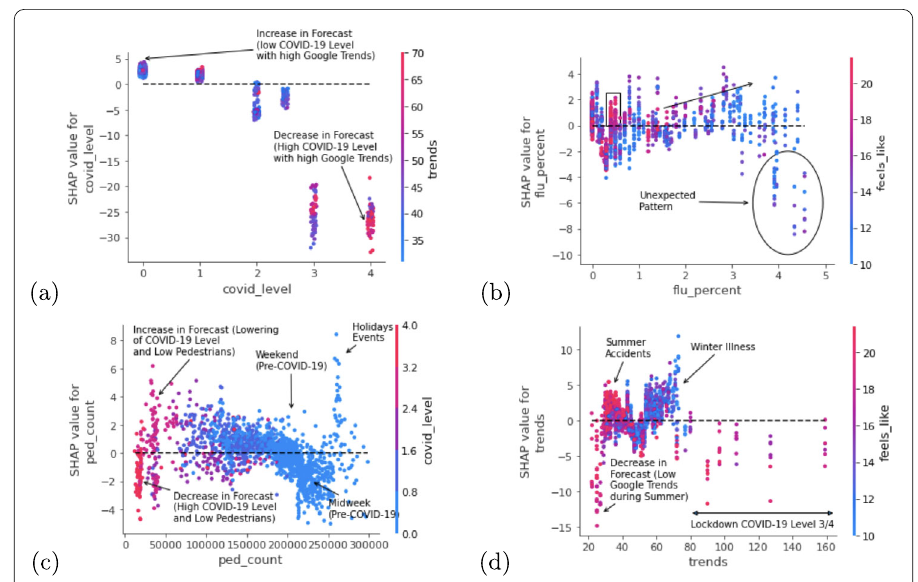
Figure 10 SHAP feature dependence plots showing interaction effects between various pairs of proxy